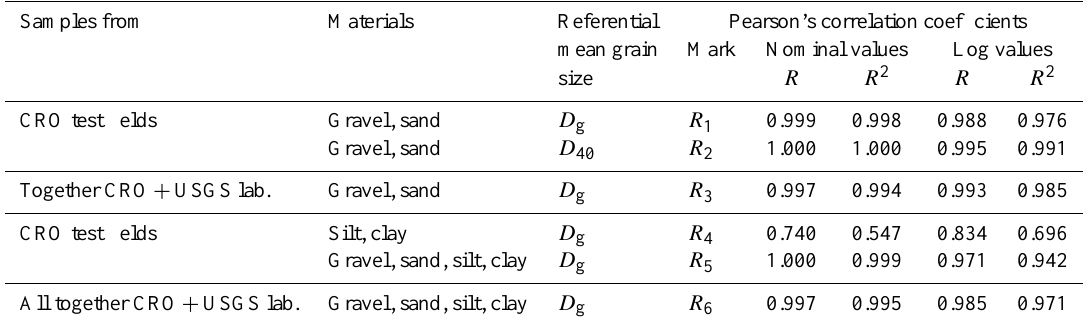
Table 3. Numerical results of correlations between tested K t and predicted K for samples from test fields in Croatia (CRO) and USGS laboratory. Samples from Materials